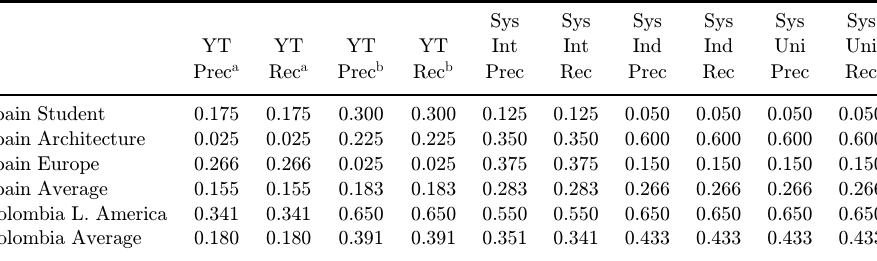
Table 6. Precision and recall scores for YouTube, and for recommendation system under interested, indecisive and uninterested settings in Spanish videos.